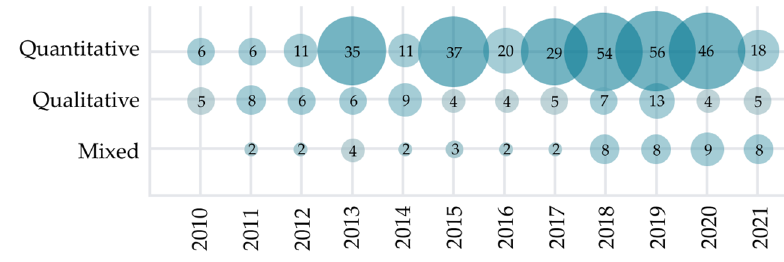
Figure 7. Number of studies by year and research type.